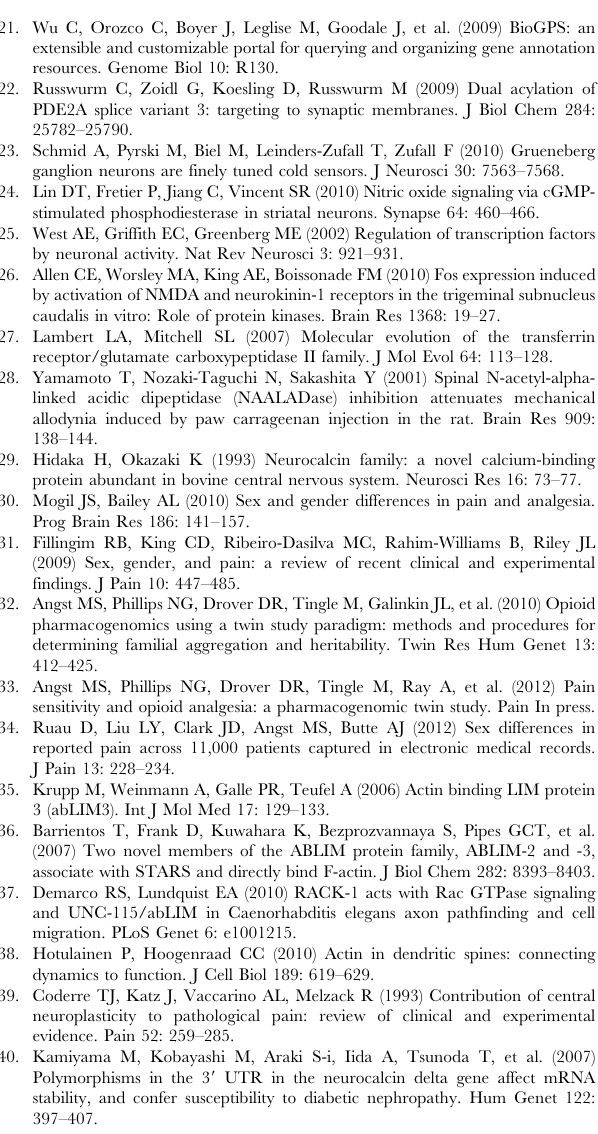
Figure S4 Manhattan plot for ABLIM3 polymorphisms when pain phenotype are quantile normalized. (A) Represent association p-values for SNPs in ABLIM3 with cold pain pressor threshold. (B) Association of ABLIM3 polymorphisms with cold pain tolerance. (C) Association analysis of ABLIM3 polymorphisms with heat pain threshold. Table S1 Disease-specific pain index (DSPI) ranking all 2962 diseases by their respective disease-pain ratio. Table S2 List of 121 diseases retrieved from GEO and AE that were also present in the